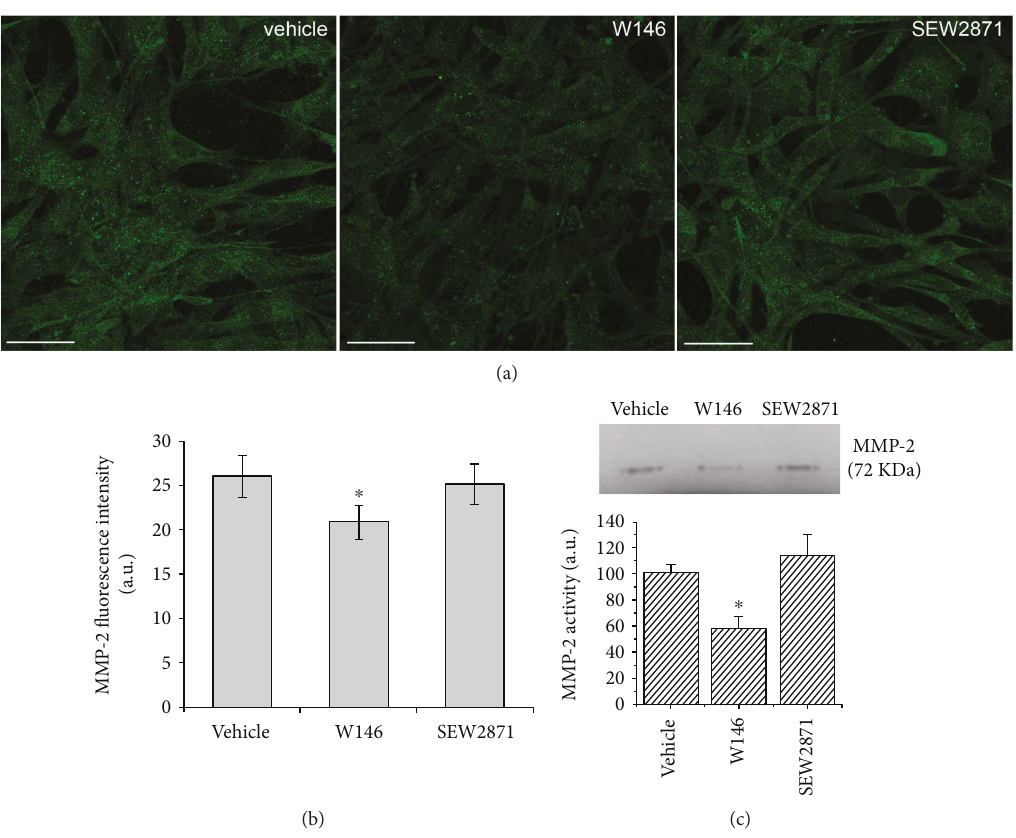
Figure 6: MMP-2 expression and activity in MSCs cultured under hypoxic conditions. BM-MSCs were cultured for 48 h under hypoxic conditions in the absence (vehicle) or in presence of 2 μ M S1PR1 receptor antagonist, W146, or 2 μ M S1PR1 receptor agonist, SEW2871. (a) Representative immuno fl uorescence confocal images of cells cultured on glass coverslips, fi xed and immunostained with antibodies against MMP-2 (green). Scale bar 50 μ m. The images are representative of at least three independent experiments with similar results. (b) Densitometric analysis of the intensity of the MMP-2 fl uorescence signal performed on digitized images. Data are mean ± S.E.M. (c) Zymography. A representative gelatin zymography of MMP-2 from conditioned media obtained from BM-MSCs incubated in the absence (vehicle) or in the presence of 2 μ M S1PR1 receptor antagonist, W146, or 2 μ M S1PR1 receptor agonist, SEW2871, for 48h. Densitometry scanning from at least three separate experiments was performed and data, expressed as relative OD values (a.u.) to those of the control group (vehicle) set to 100, are reported in the histogram. Data are mean ± S.E.M. Signi fi cance of di ff erences in (b) and (c) (Student ’ s t -test): ∗ p < 0 05 versus